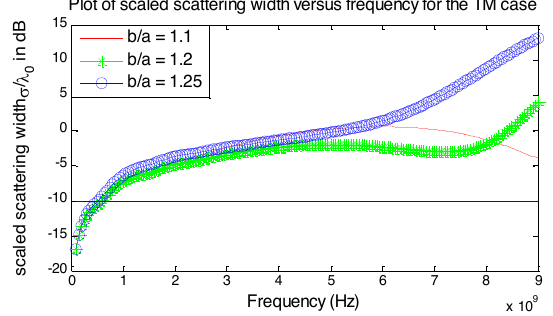
FIGURE 4. Normalized backscattering width (TM polarization) versus frequency of Rods only media coating for b/a = 1.1, 1.2 and 1.25 with fixed c/a = 1.3